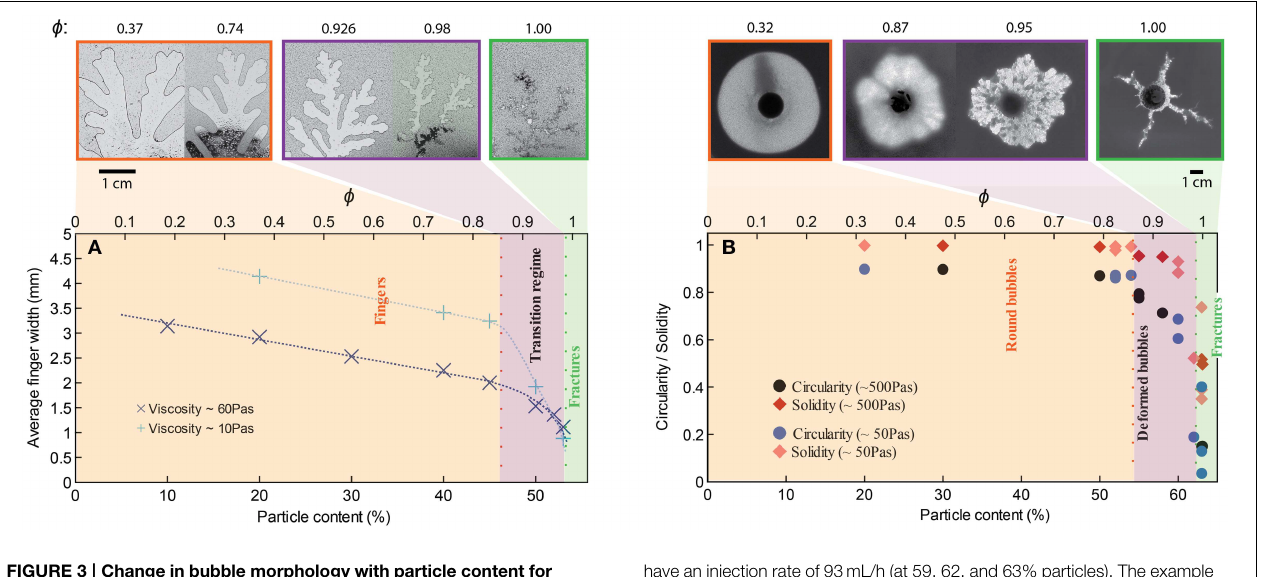
have an injection rate of 93mL/h (at 59, 62, and 63% particles). The example experiments displayed above the graphs have a liquid viscosity of ∼ 10 Pa s (small-gap), and ∼ 50 Pa s (large-gap geometry). In all geometries and for all liquid viscosities, a change in bubble morphology occurs around φ ≈